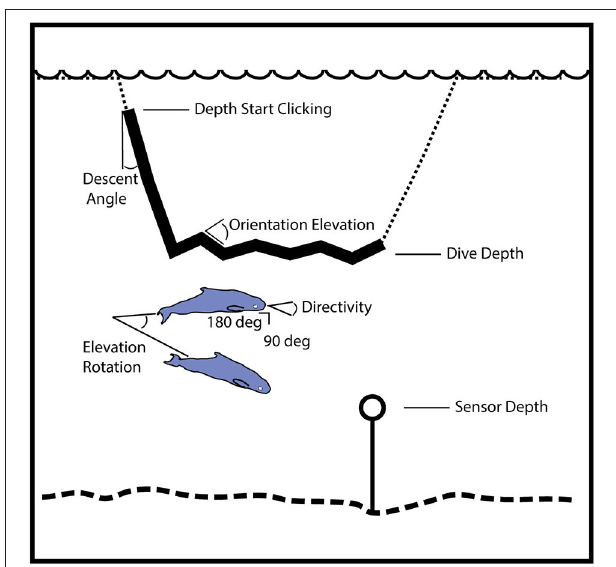
FIGURE 2 | Illustration of geometry for model parameters used to simulate the probability of click and group detection with range. The simulation distributes animal locations and orientations using these parameters, and then tests for echolocation click detection at the sensor. Dive track (dotted line) with portion containing echolocation (solid line) during descent phase and at the dive depth during foraging phase. Beam pattern is given by the directivity, side-lobe (90 ◦ ) source level and back-lobe (180 ◦ ) level. For a group of animals, the larger number of animals and differences in their body orientation (elevation and azimuth) increase the detection probability during a fixed time window (one-min). A minimum beam amplitude is designated for the group when the sensor is outside the range of orientations where an on-axis click would be